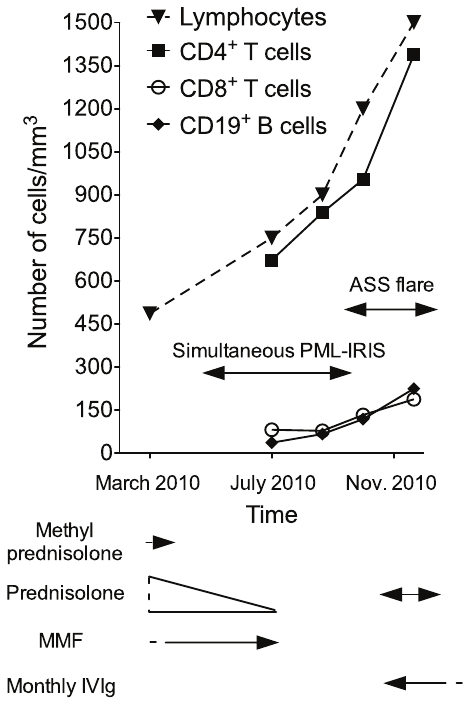
Figure 1. Course of blood lymphocytes according to symptoms and therapy. Arrows underneath the graph represent treatment periods. Single arrow heads represent treatments that were begun or stopped outside of the time period represented on the graph. ASS: Anti-synthetase syndrome; MMF: mycophenolate